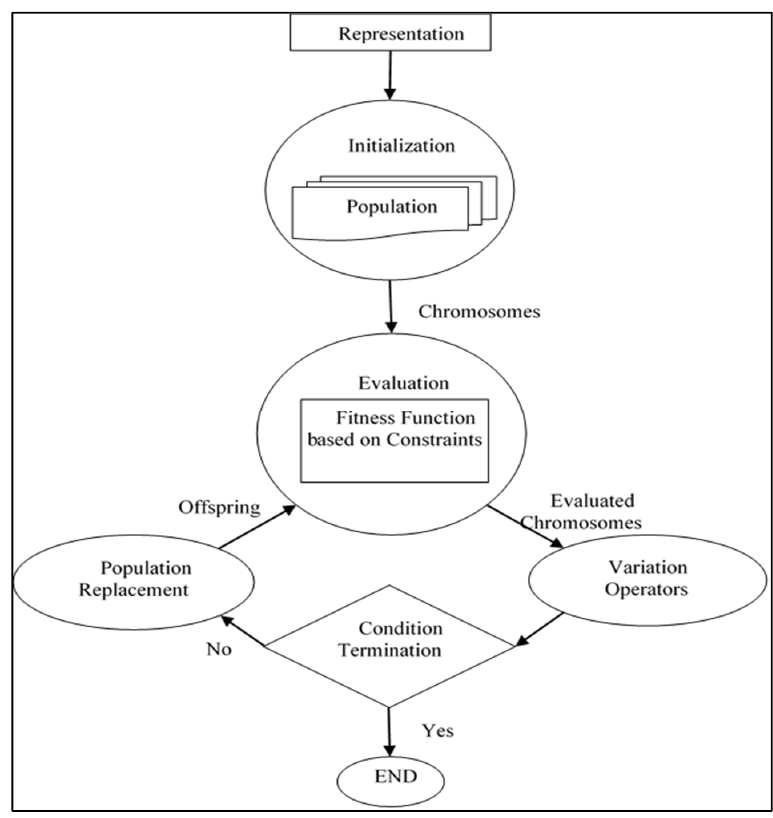
Figure 3 . Designed GA flowchart. Figure 3. Designed GA